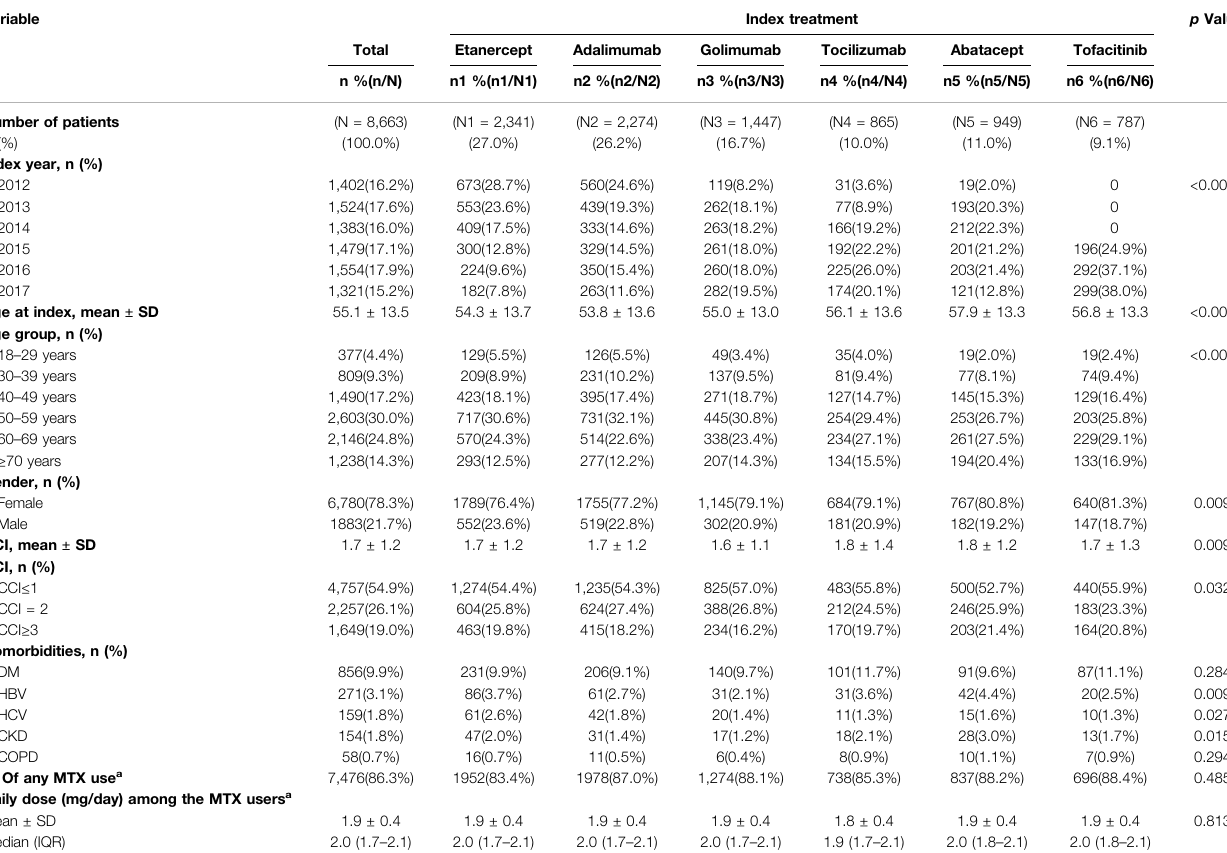
TABLE 1 | Baseline characteristics and treatment patterns of patients by index treatment.